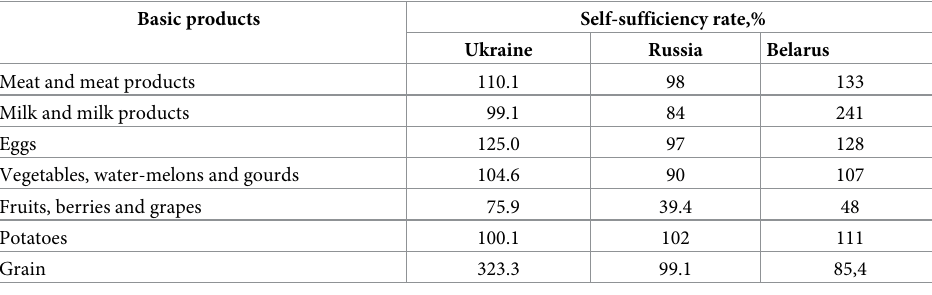
Table 7. Self-sufficiency by basic food-stuffs in 2020 (output for domestic use). Basic